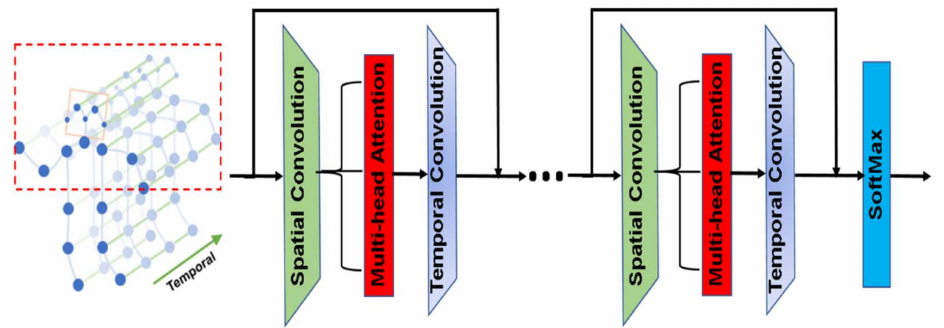
Figure 5. The proposed 3DGCN